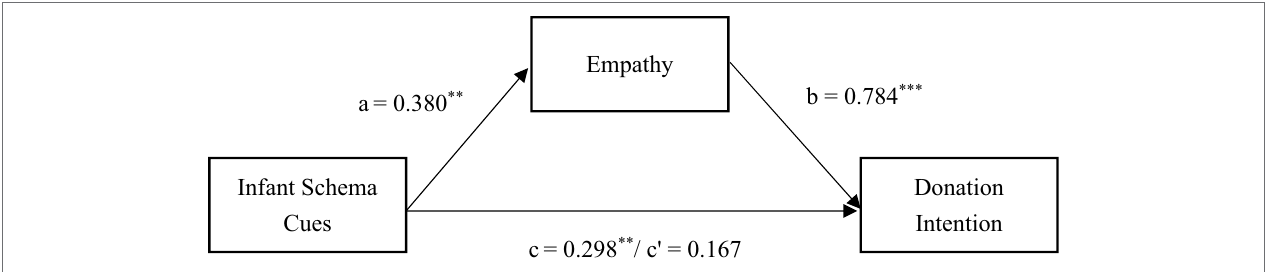
FIGURE 3 | Mediating test of the influence of infant schema on donation intention. *** p < 0.001, ** p < 0.05; c represents the coefficient of direct effect, c’ represents the coefficient of indirect effect.